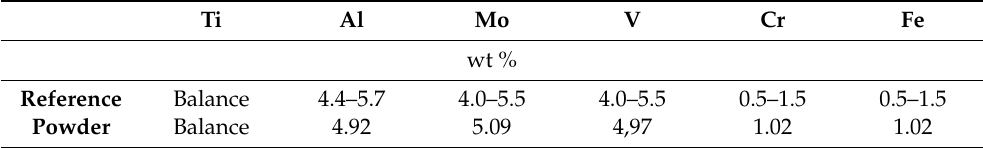
Table 1. The chemical composition of Ti-55511 alloy according to the certificate provided by the manufacturer.